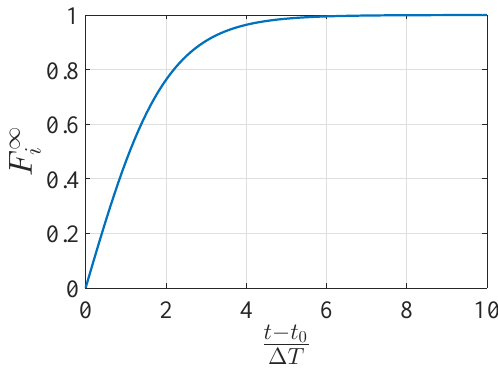
Figure 3. Fault transient